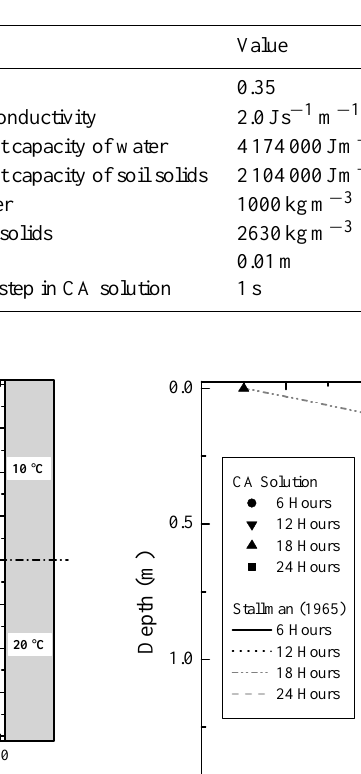
Table 1. Simulation parameters for heat conduction problems. Analytical solution for this example is given by Eq. (13) as per Churchill (1972).